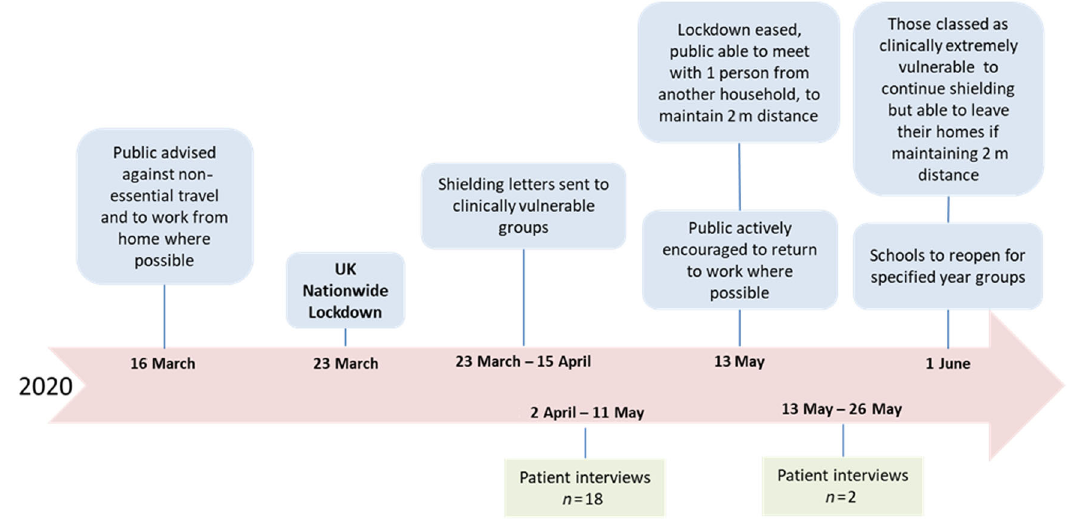
Fig. 1 Interviews timeline. Timeline of the interviews in relation to government guidance and the lockdown